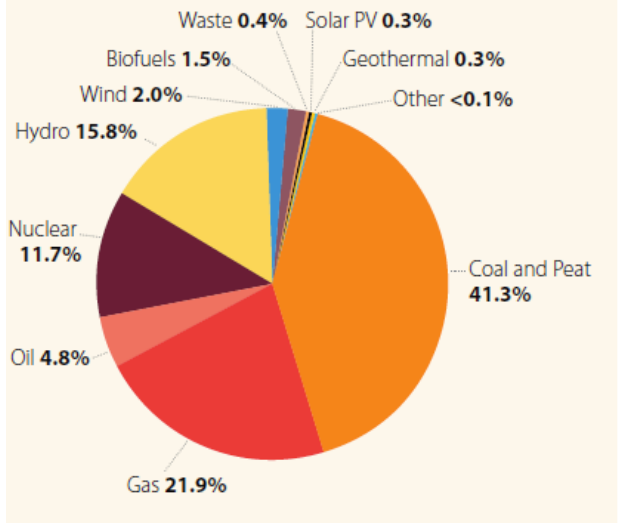
Fig. 2 World electricity generation by source of energy as a percentage of world electricity generation. Source: WWAP 2014 (Fig. 3.5, p. 34). ENERGY FOR WATER: THE OTHER SIDE OF THE